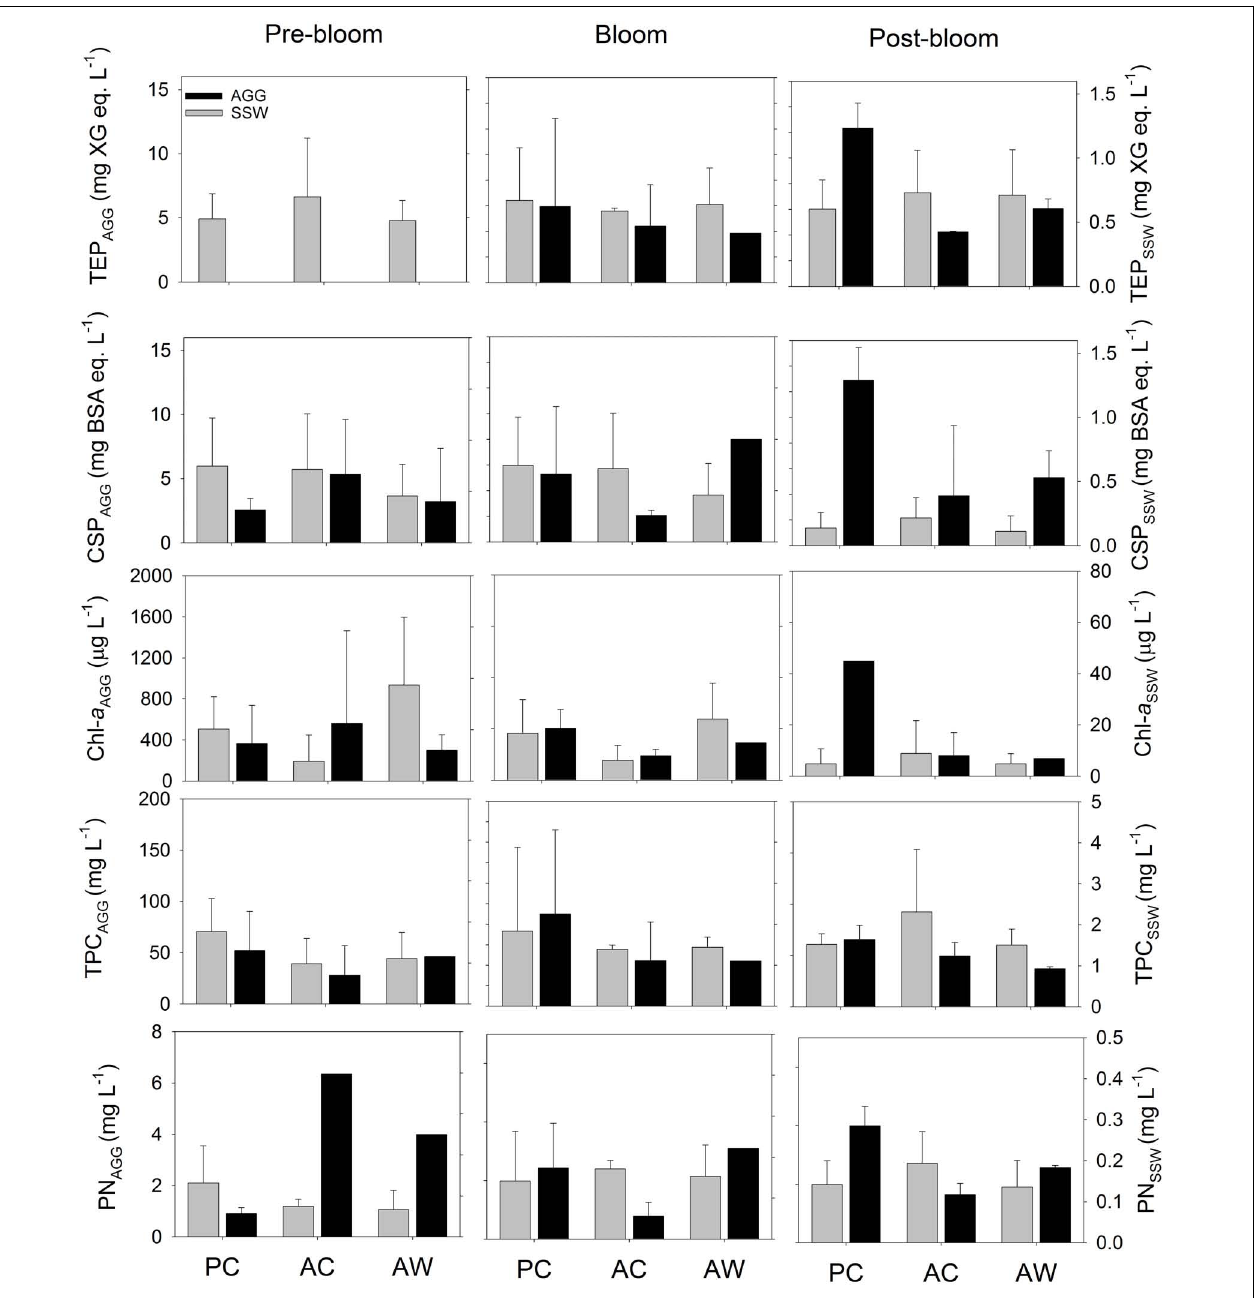
bloom period. For Pre-bloom: PC ( n = 3RT), AC ( n = 4 RT), and AW ( n = 2RT); and for Post-bloom PC ( n = 2 RT), AC ( n = 2 RT), and AW ( n = 2